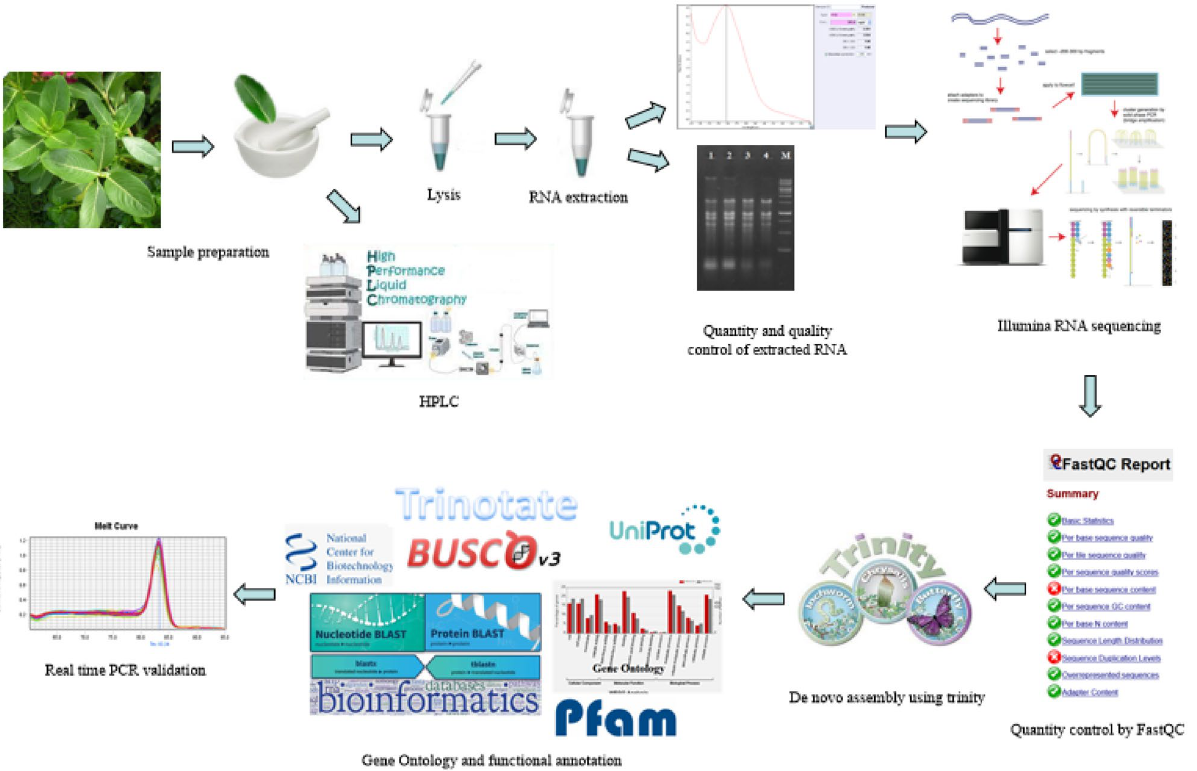
Figure 7. Schematic illustration of different steps taken for